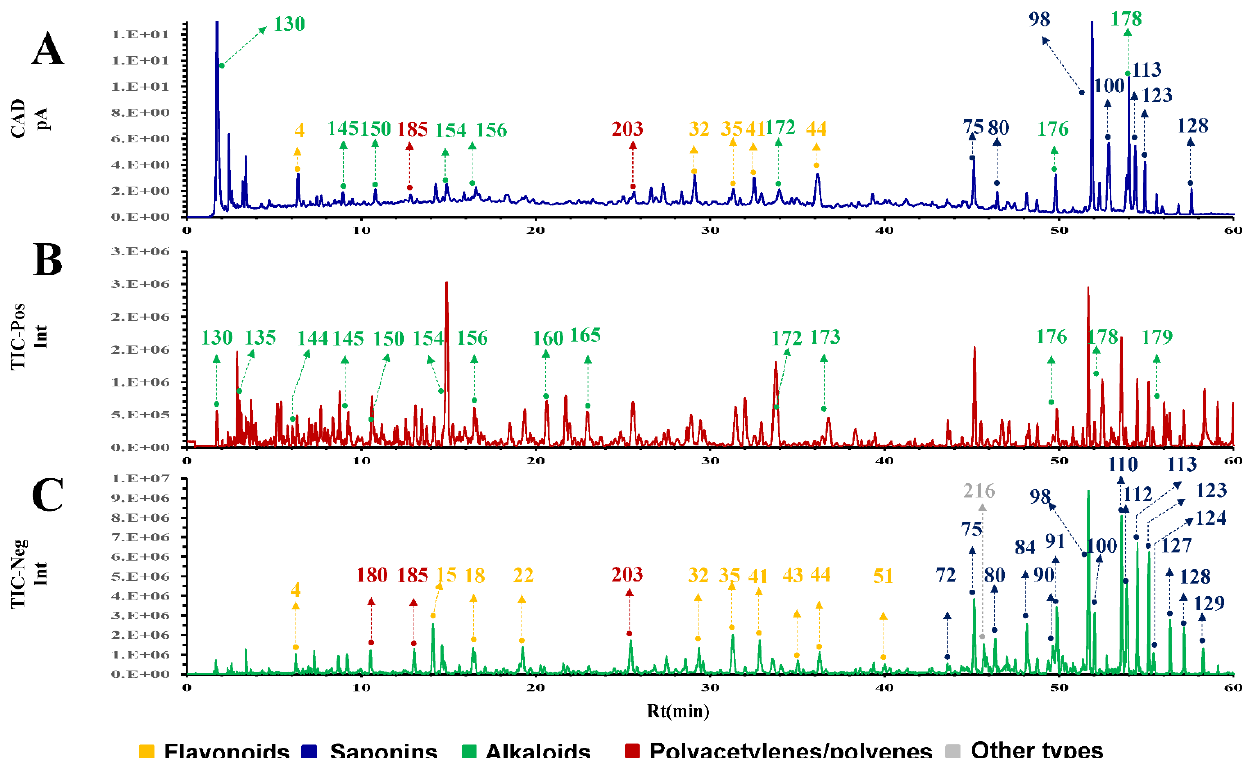
Figure 1. TIC diagrams in the positive and negative ion modes of UHPLC-CAD fingerprint estab- lished for the Shenqi Fuzheng injection (SFI). (( A ), SFI fingerprint; ( B ), TIC diagram of SFI in positive ion mode; ( C ), TIC diagram of SFI in negative ion mode).